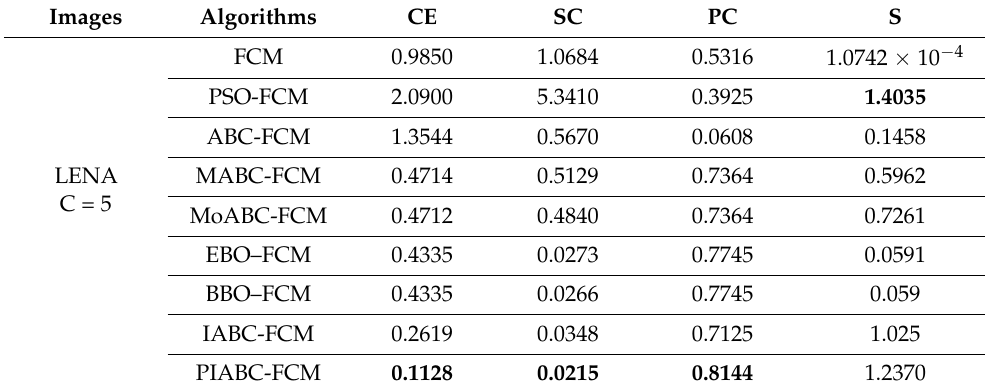
Table 2. Outcomes of PIABC-FCM and other clustering algorithms on Lena